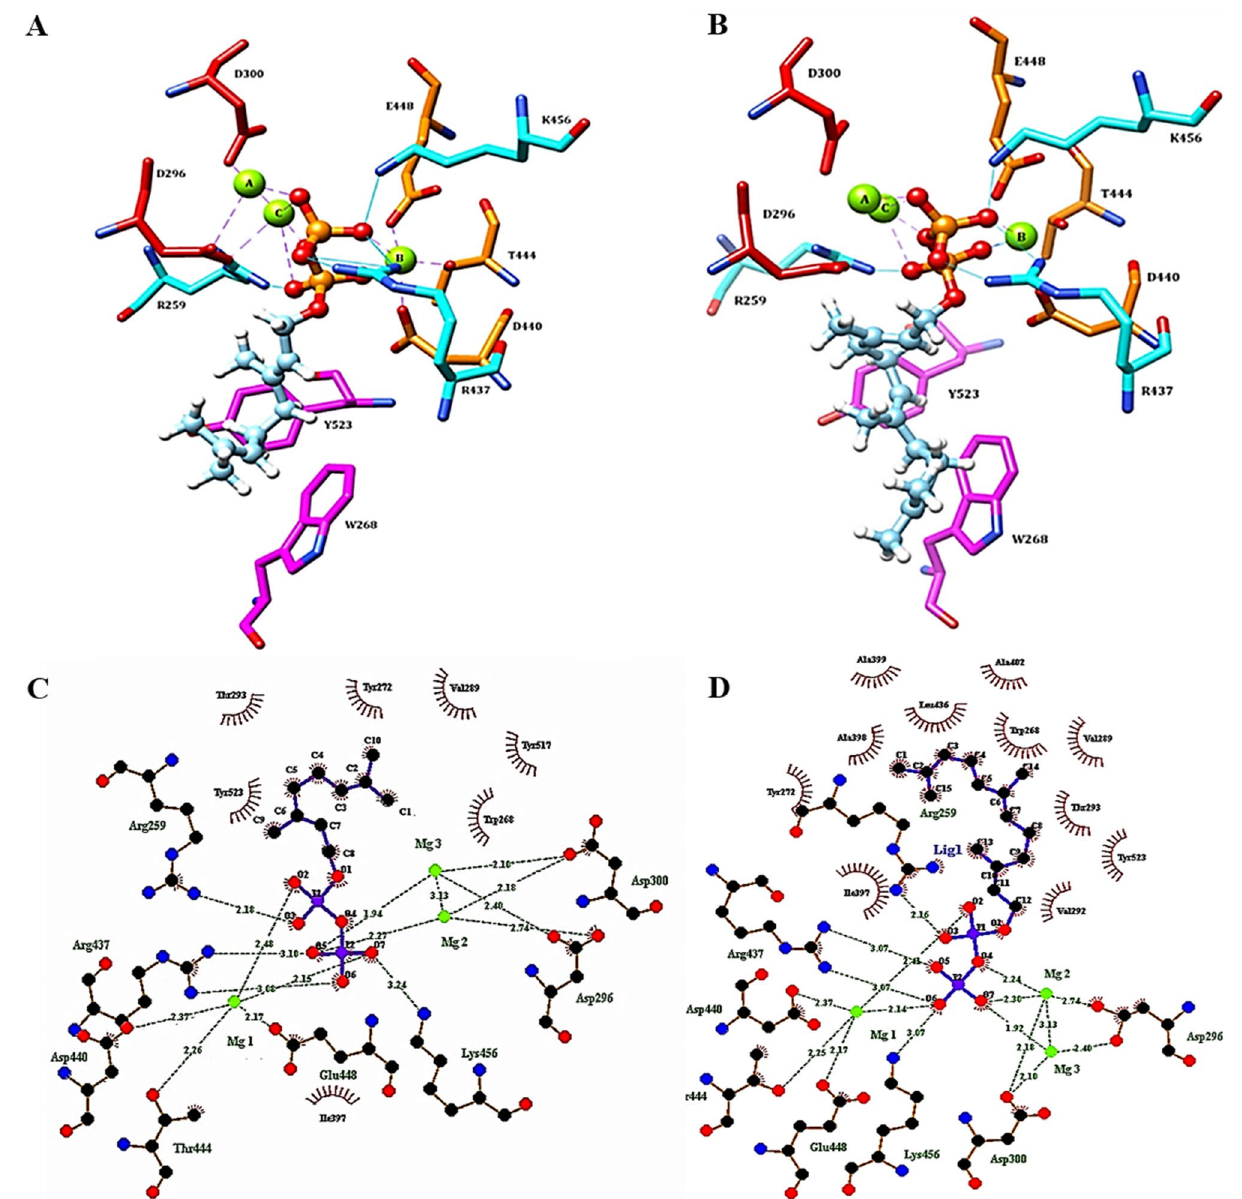
Figure 4. Ligand- Pam Tps1 interactions. Three-dimensional (3D) view of ( A ) GPP and ( B ) FPP docking at Pam Tps1 active site. The red–orange balls and stick chains represent PPi, green spheres are the Mg 2+ , the red side chains are the DDxxD motif, the orange side chains are the DTE motifs, the blue side chains are the hydrogen bond donor residues, the magenta side chains represent the aromatic residues and the cyan lines are the hydrogen bonds. Two-dimensional (2D) view of ( C ) GPP and ( D ) FPP docking at Pam Tps1 active site. Hydrogen bonds are shown as green dotted lines, Mg 2+ are shown in green spheres and spoked arcs represent residues making non-bonded contacts with the hydrophobic tail of the ligand. Details of the docking result are summarized in Table Docking of GPP and FPP substrates confirmed that the active site of Pam Tps1 was located at the C-terminal domain, proximate to the location of the Mg 2+ cofactor (Fig. 4). A two-dimensional representation of Mg 2+ interaction with the amino acid residues and substrate (ligand) was displayed in Fig. 4C,D. This concurred with earlier observations using SWISS-MODEL and InterProscan that the diphosphate (PPi) moiety of the prenyl substrates interacted with the highly conserved aspartate-rich ( D 296DVY D 300) and NSE/DTE (LA D 440DLG- T 444APF E 448) motifs via complexed Mg 2+ , in which the boldface residues were coordinated to the metal ions. The first and third aspartate residues in the aspartate-rich motif, D296 and D300, were coordinated to Mg 2+ A and Mg 2+ C , which were identical to the BPPS, avian FPP synthase 67 , taxadiene synthase 9 , and M. spicata limonene synthase 6 . The second metal-binding region comprised of D440, T444 and E448 of the helix H coordinated to the Mg 2+ B . Similar metal ion coordination by the corresponding residues was also observed in trichodiene